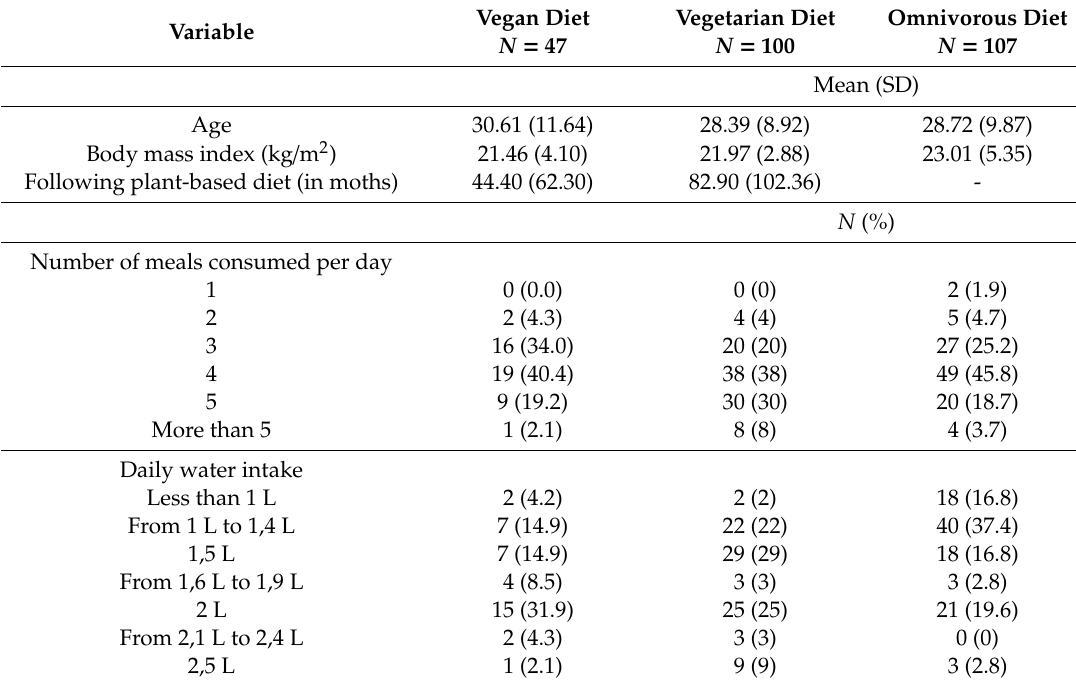
Table 3. Descriptive characteristics of the study